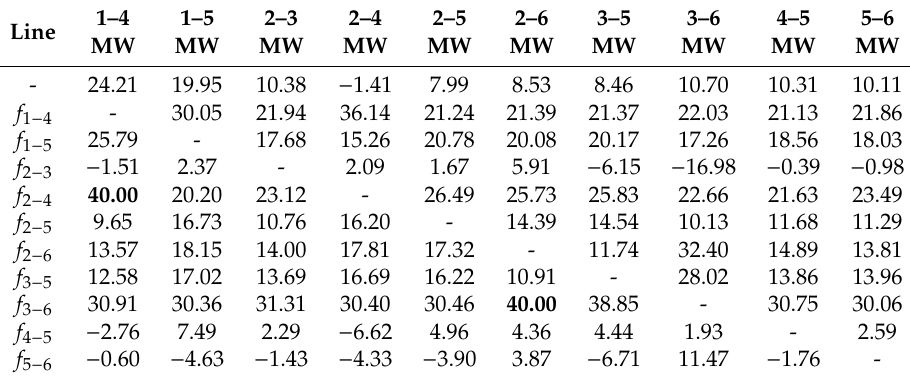
Table 3. Power flow solution for each N − 1 transmission